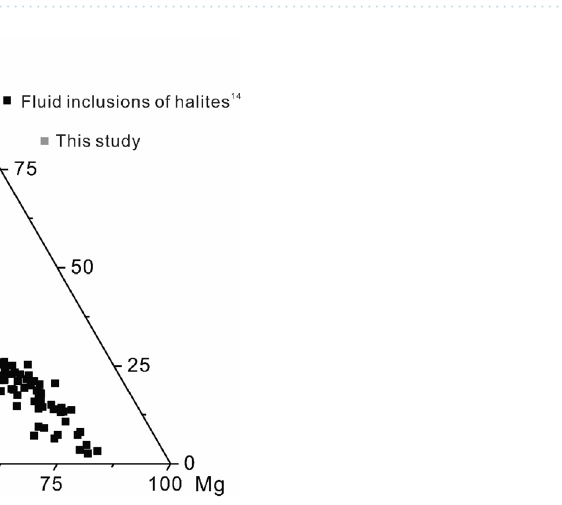
Figure 5. K and Mg vs. Br of halite samples from Hole K203, ( a ) K vs. Br; ( b ) Mg vs. Br.